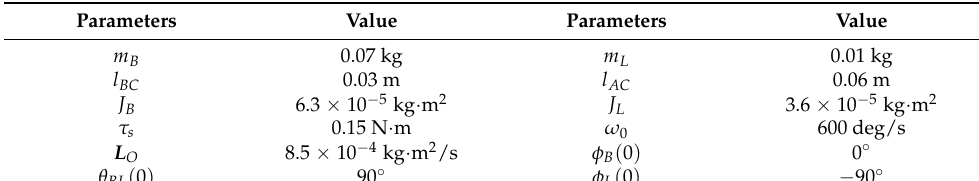
Table 1. MATLAB simulation parameters.